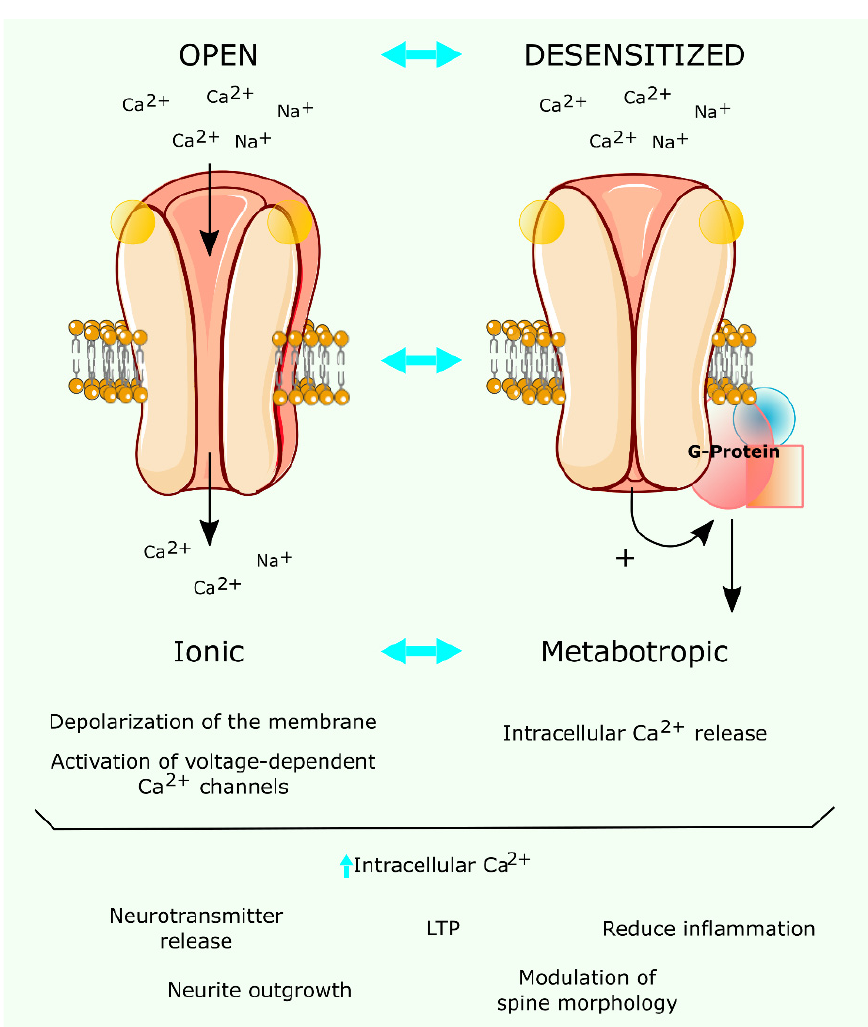
Figure 1. Ionotropic and metabotropic signaling of α 7 nAChRs. Ionotropic signaling (left flow chart): upon ligand binding, the homomeric α 7 nAChR channel opens, allowing the flux of Ca 2+ and Na + into the target cell, which produces the depolarization of the membrane. This triggers the opening of voltage-activated Ca 2+ channels and the intracellular Ca 2+ concentration increases further. Metabotropic signaling (right flow chart): sustained exposure to the agonist shifts the α 7 nAChR conformation to the desensitized state, under which ACh or exogenous agonist molecules are bound to the oligomer, but the channel remains closed, and no ion permeation occurs. However, desensitized α 7 nAChRs can couple to G-proteins that activate a cascade of signals ending in the release of Ca 2+ from intracellular stores (e.g., the endoplasmic reticulum). These signaling cascades may have different effects depending on the nature of the